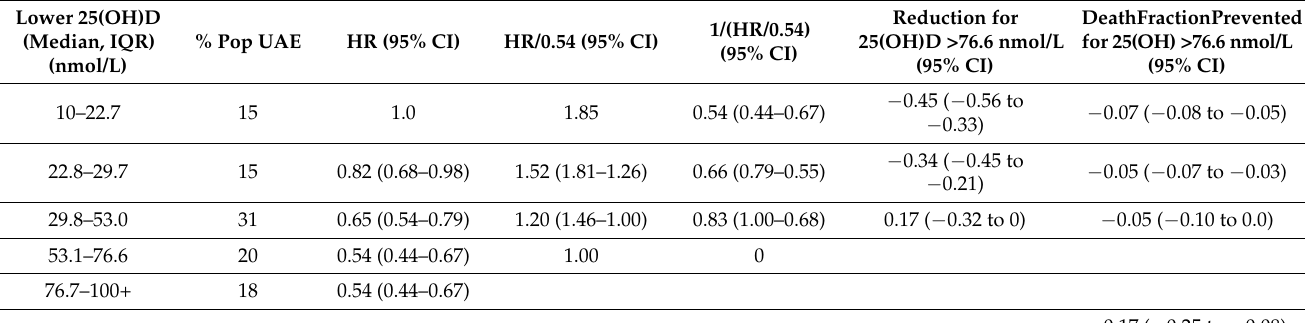
Table 8. Estimate of reduction in CVD mortality rate in the UAE by raising minimum 25(OH)D concentration to 30 ng/mL using 25(OH)D data from [85] and CVD results from the UK [79].